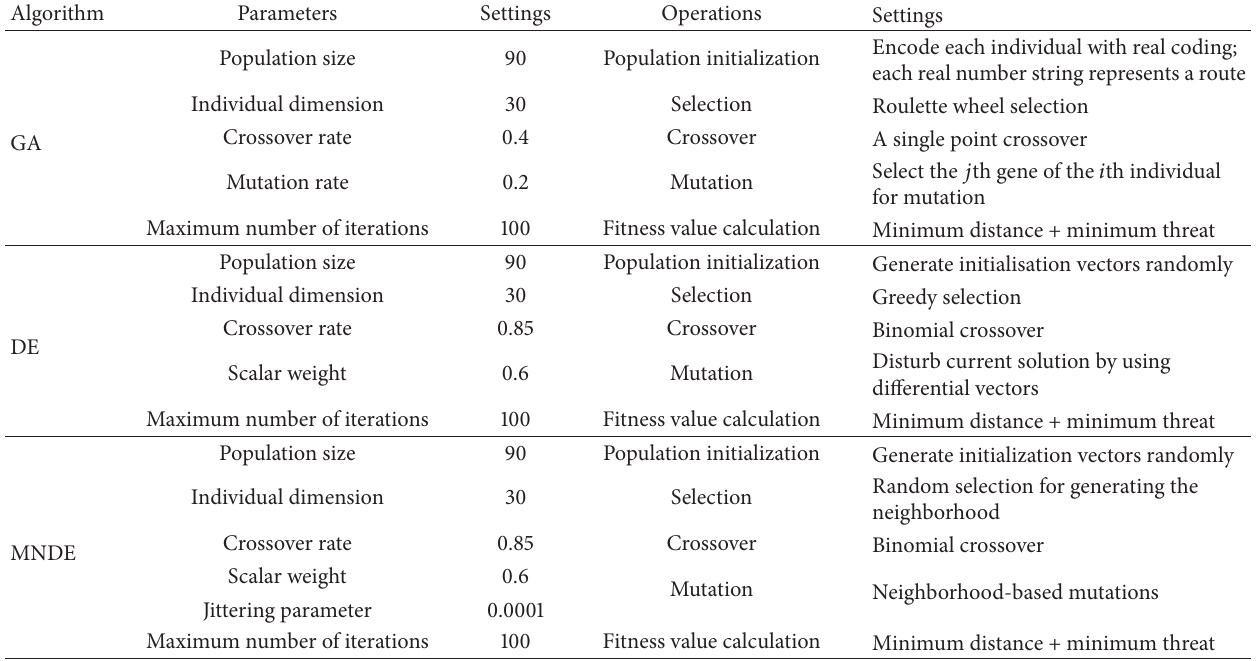
Table 4: Settings and operating rules of the three optimizing algorithms.